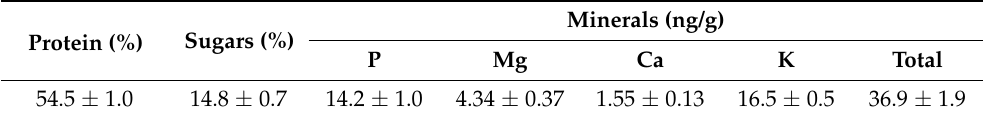
Table 3. Protein content (% w / w ), sugars (% w / w ) and minerals (ng/g extract) of peptide-rich extract obtained from autolysis of